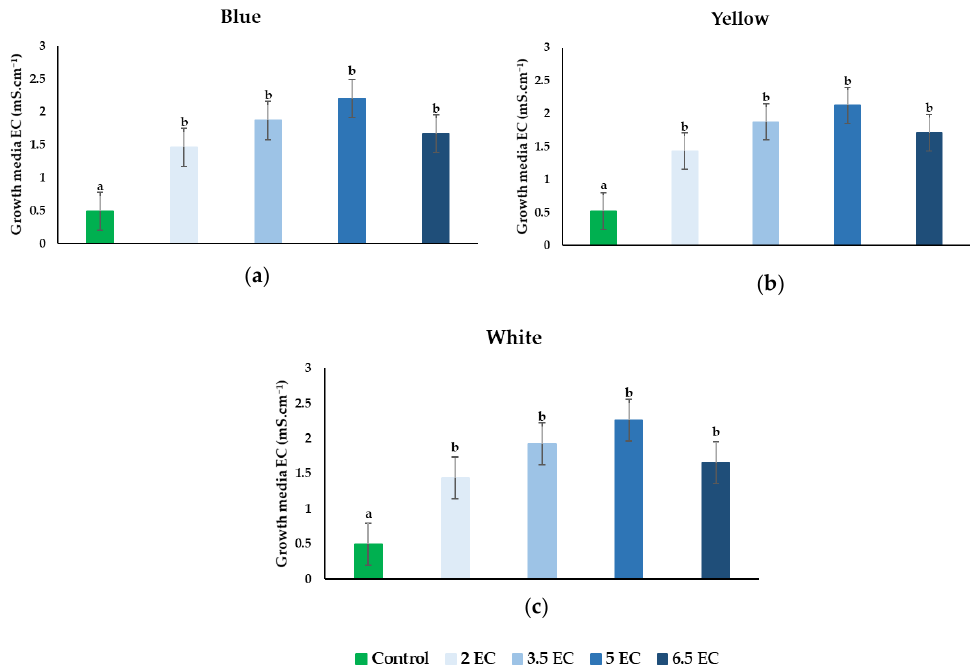
Figure 2. Effect of nutrient solution electrical conductivity levels 1 (control), 2, 3.5, 5, and 6.5 mS cm − 1 ECon growth media EC of the selected Viola × wittrockiana seedlings: ( a )—Blue, ( b )—Yellow, and ( c )—White. Bars represent the means ± SE ( n = 40). Different letters indicate significant differences between treatments ( p < 0.05).